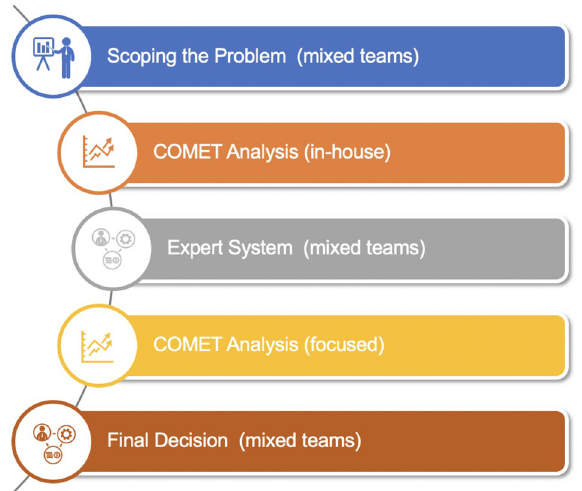
Figure 9. An intelligent framework for MCDA use in offshore